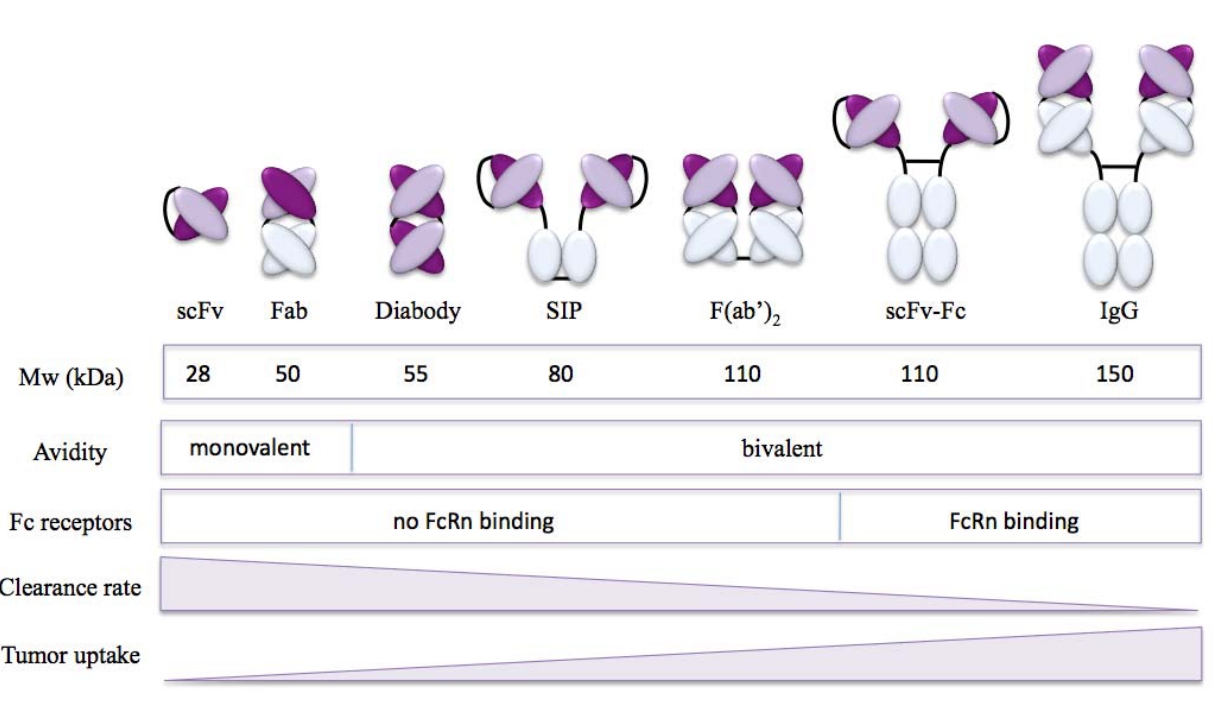
Figure 1. Antibody formats used for the development of immunocytokines and their targeting